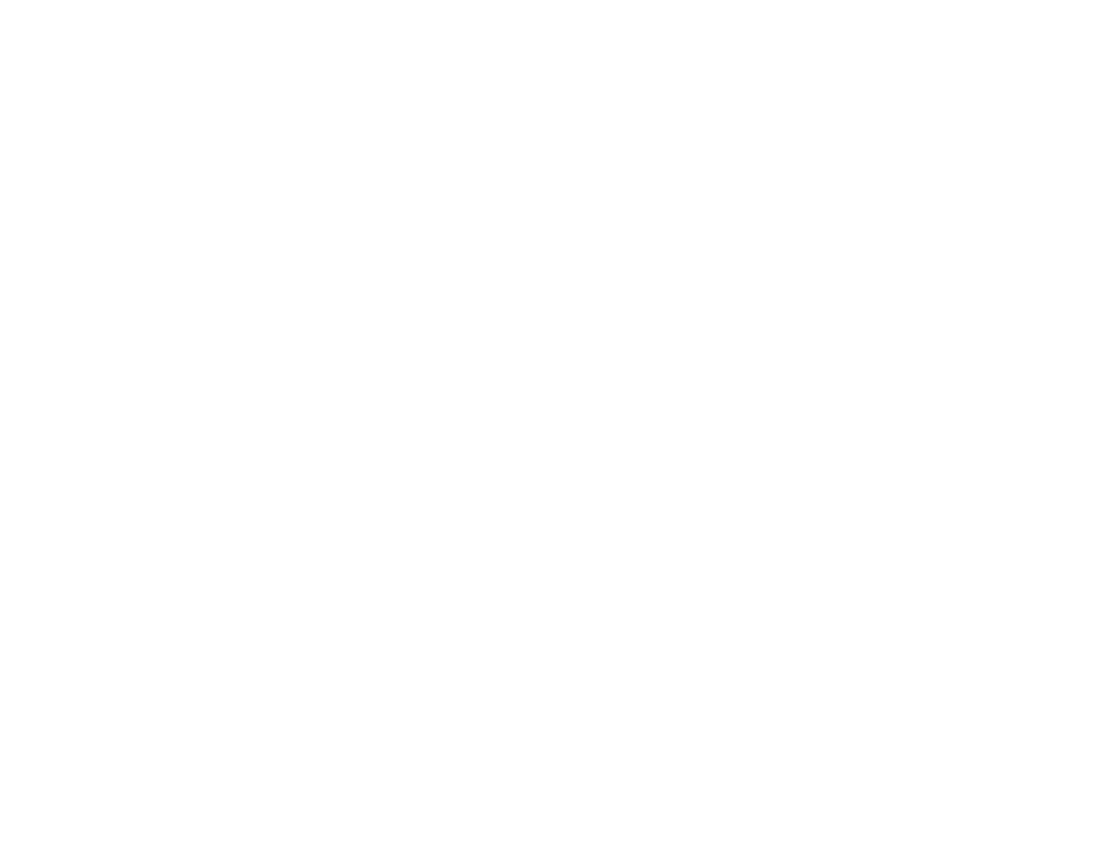
points (1, 2, 5, 8, 10, 15, 20, and 30min) in Sm CD27 + and Sm CD27 − B cell populations (A) . Samples were fluorescently barcoded for multiplexing. Displayed are detailed histograms of pSyk following anti-IgA (B) and -IgG (C) at each time